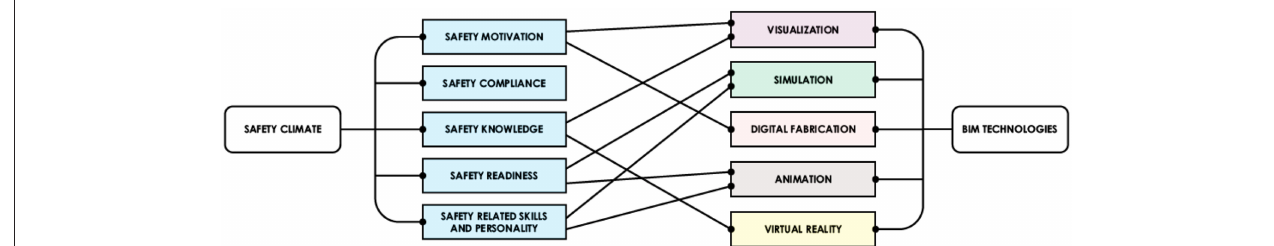
FIGURE 7 | Relationships between BIM technologies and safety climate.